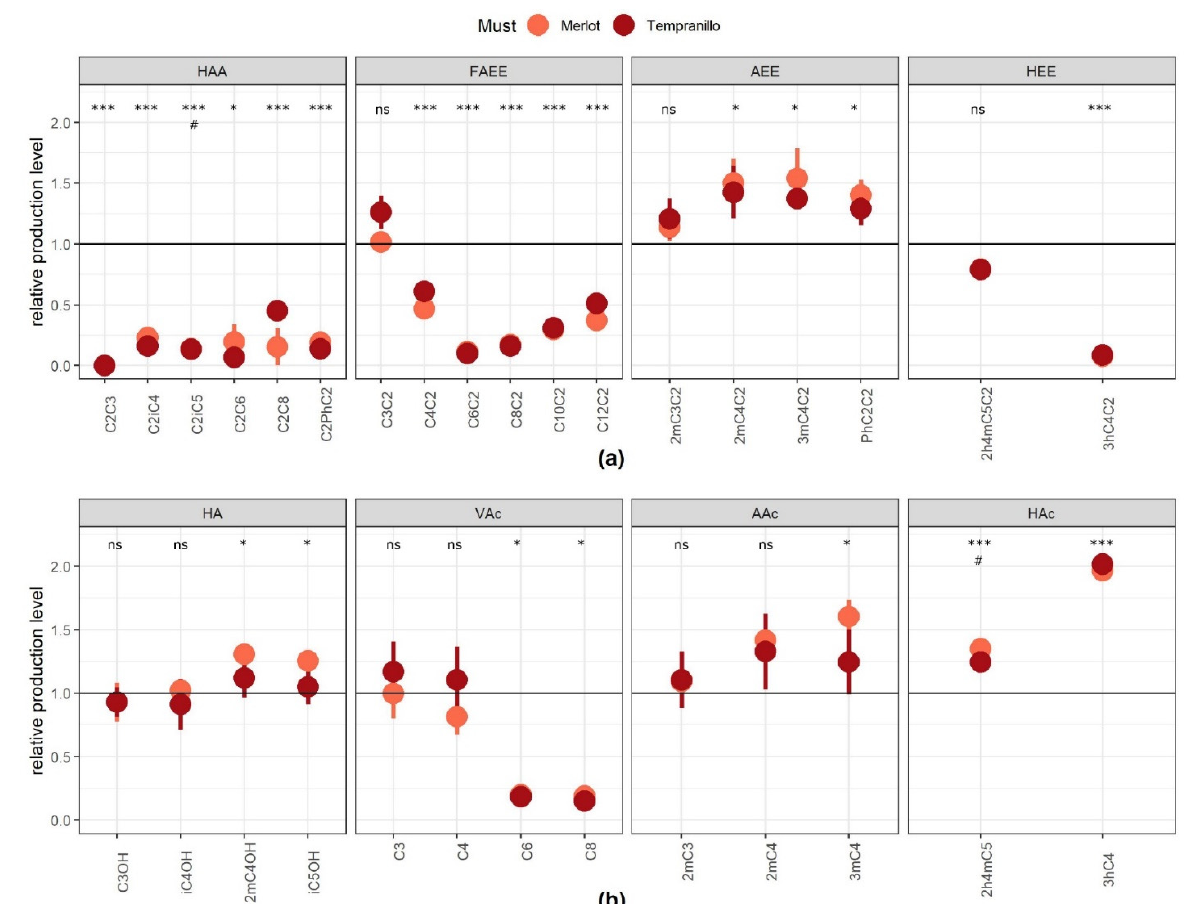
Figure 2. Relative production of esters and their metabolic precursors in a nearly “esterase free” strain. Raw values of the strain Fx10- ∆ AE were normalized by the average value of the control strain Fx10. ( a ) The panel shows the relative production of each compound of the four ester families in both grape musts (Merlot and Tempranillo). ( b ) The panel shows the relative production of each metabolic precursor compound of each family in two grape musts. Each point and bar represents the mean and the standard error computed from 3 independent biological repetitions for each grape must. The symbols * and *** indicate which compounds have a significantly different production level with respect to the wt (post hoc HSD test based on the ANOVA, α = 0.05 and 0.001, respectively). The symbol # indicates which compounds have a significantly different production level according to the grape must origin (post hoc HSD test based on the ANOVA α = 0.05).